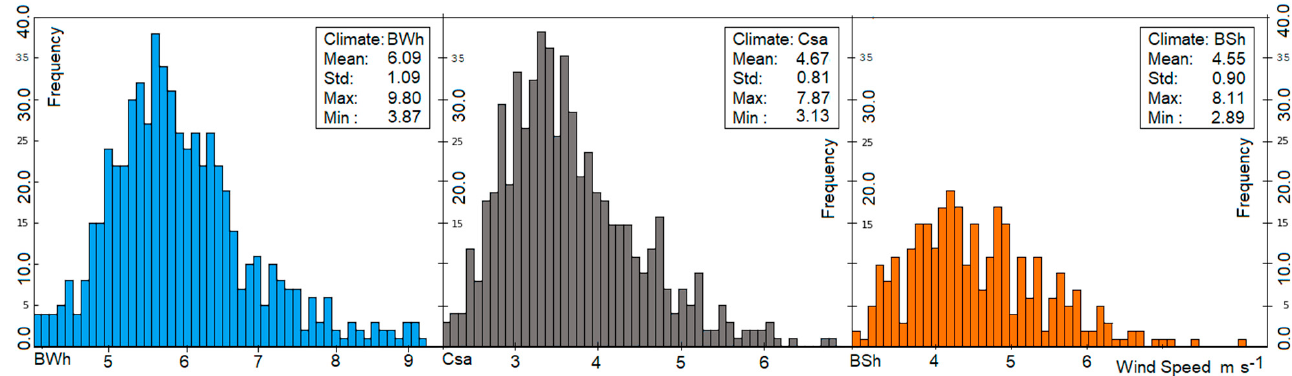
Figure 5. Histogram of wind speed (m s − 1 ) monthly averages for 2014–2017. From left to right: Vertical axis shows event frequencies and horizontal axis represents wind speed in BWh, Csa, and BSh.